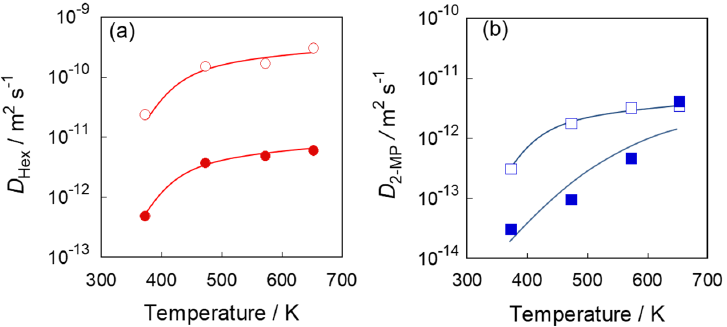
Figure 5. The temperature dependency of the diffusion coefficient of ( a ) n -hexane, ( b ) 2-methylpentane. Open and solid symbols show S-1 S and S-1 M , respectively.